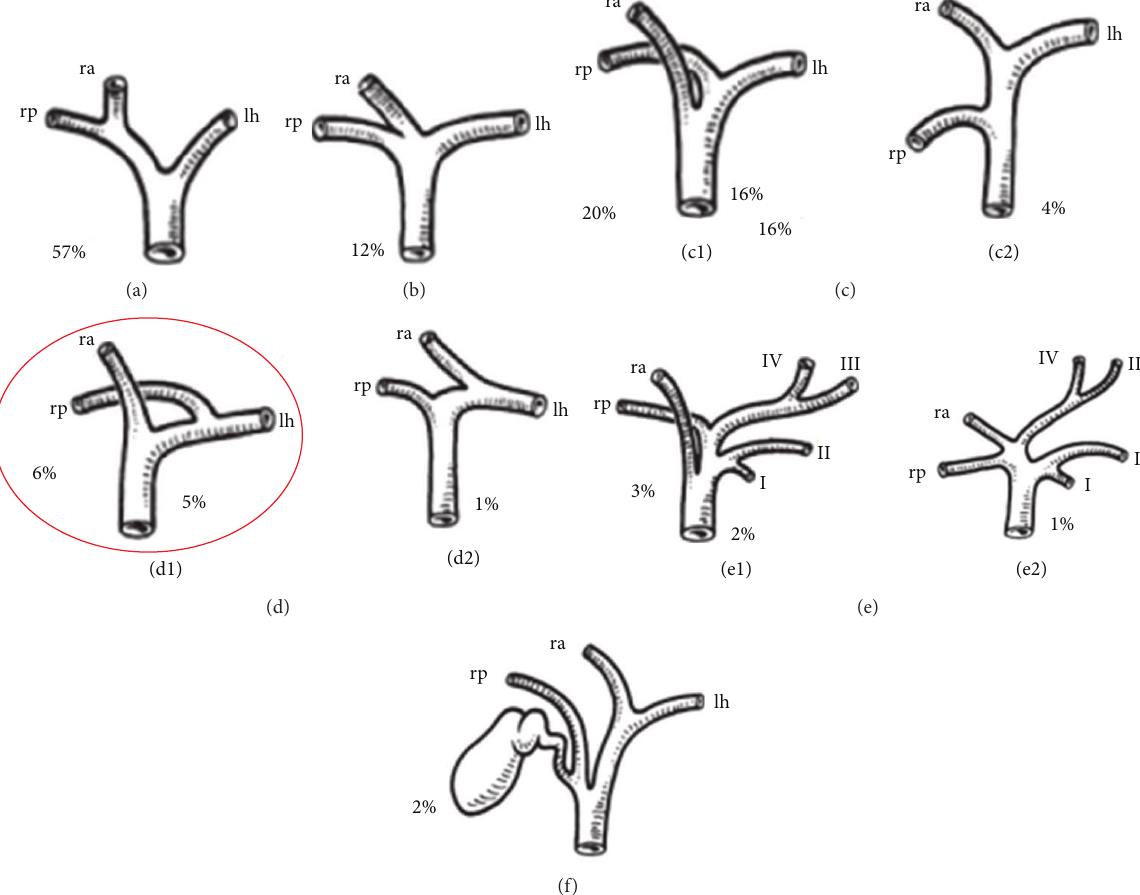
Figure 7: Normal hepatic duct anatomy and common variations (Couinaud 1957). (a) Typical anatomy. (b) Triple confluence. (c1) Right anterior draining into common hepatic duct. (c2) Right posterior duct drainage into common hepatic duct. (d) Right sectoral duct into the left hepatic ductal system. Red circle indicates the anatomy of the patient in this study. (e) Absence of confluence. (f) Absence of right hepatic duct. Drainage of right posterior duct into the cystic duct. The circled image corresponds to the biliary anatomy of this patient. Adapted and with permission to publish from Surgery of Liver, Biliary tract, and Pancreas, L. H. Blumgart editor. (2007, Saunders Elsevier: Philadelphia page